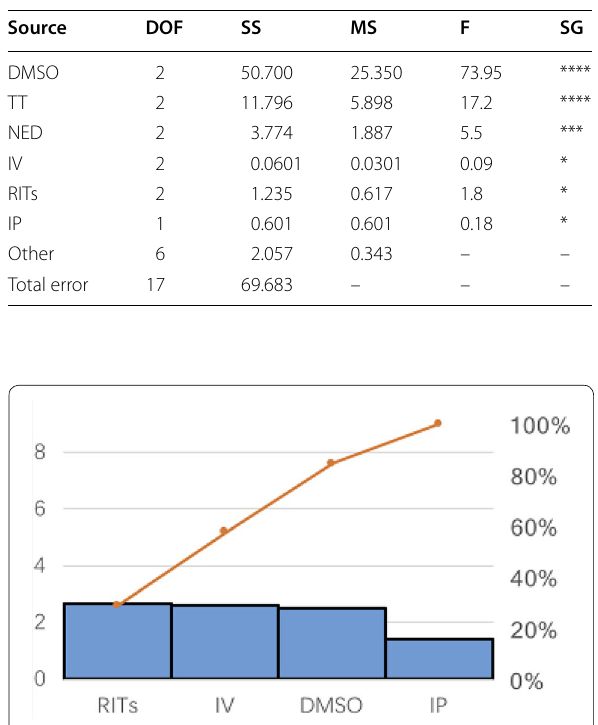
Table 7 Variance analysis on MND